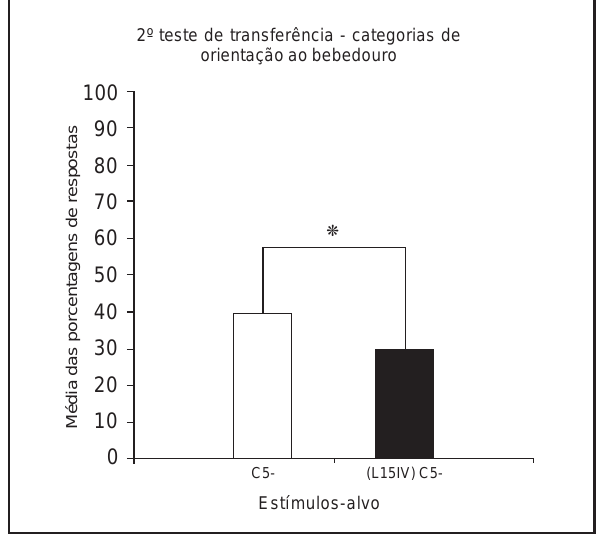
Figura 6. Média das porcentagens de resposta das categorias agrupadas ( head-jerk +lamber e\ou farejar o bebedouro) nas práticas L5 IV C15- e C15- no 2o teste de transferência. L= luz; C= Clique; IV= intervalo vazio. (Durante a fase de aquisição as práticas foram: L15 IV T5+; T5-; L5 IV R15-; R15+). Diferença estatística